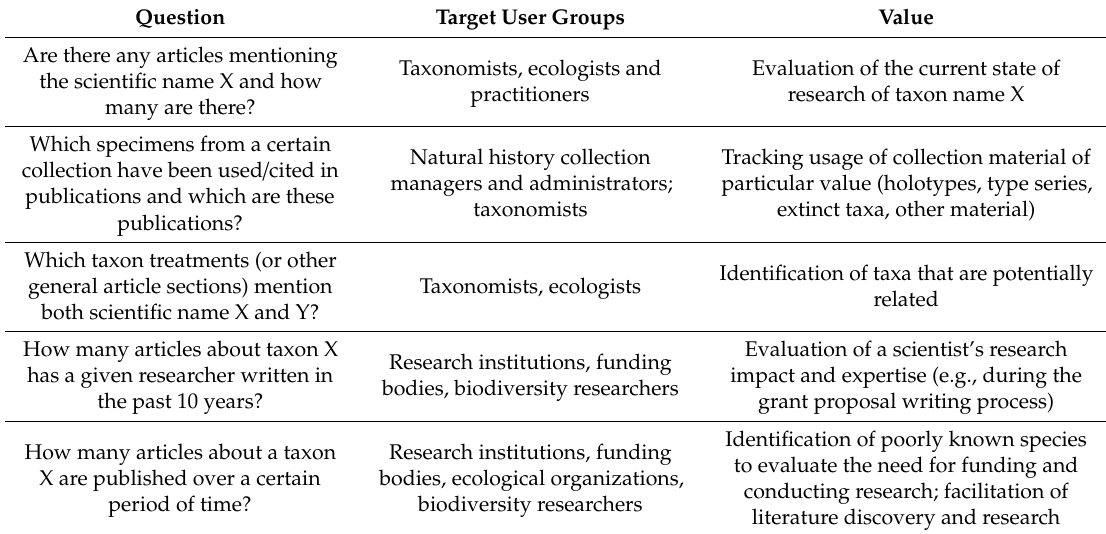
Table 3. Examples of competency questions and user stories that can be addressed by